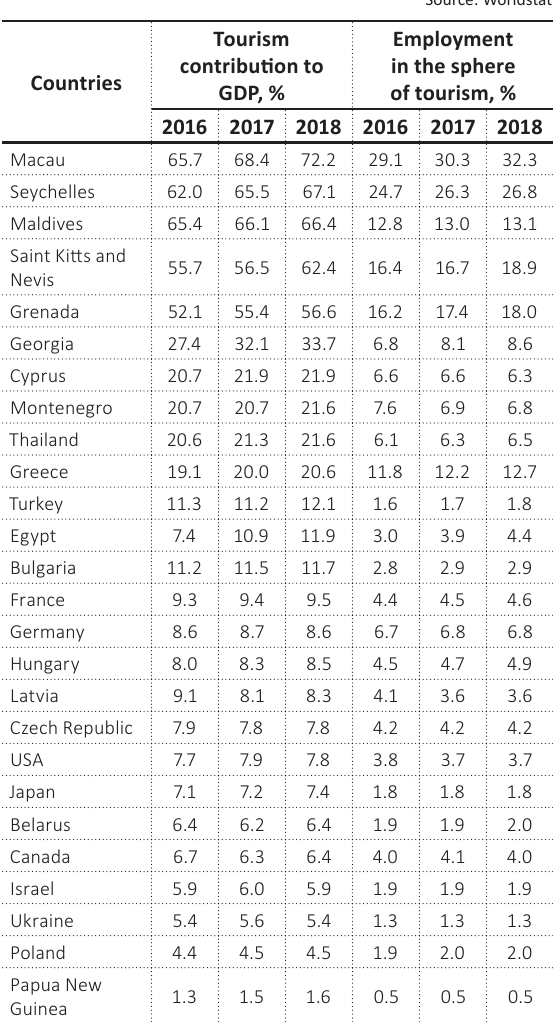
Source: Worldstat.